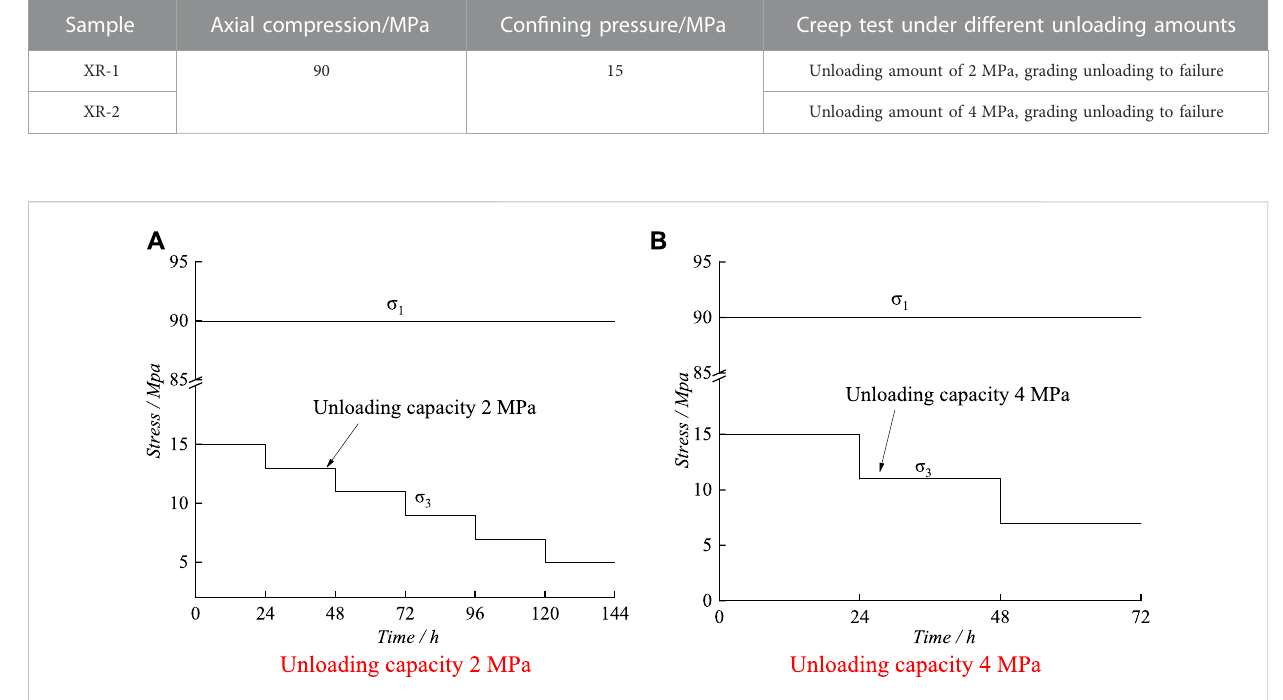
FIGURE 3 Stress path diagram of stepped unloading. (A) Unloduading capacity 2 MPa (B) Unloading capacity 4